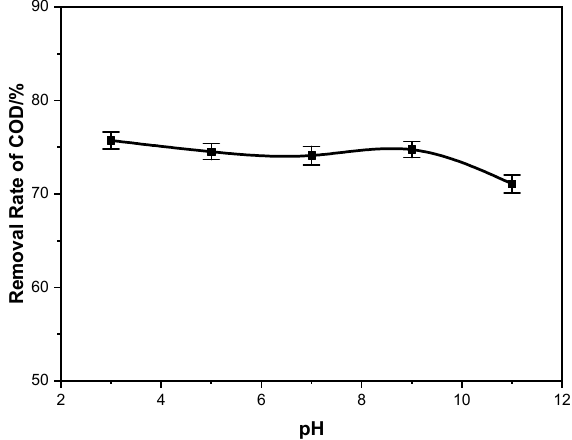
Figure 5. Effect of initial pH value on mixed wastewater COD removal rate (anode material: Fe, cathode material: Stainless steel, current density: 19.23 mA/cm 2 , electrolysis time: 50 min).